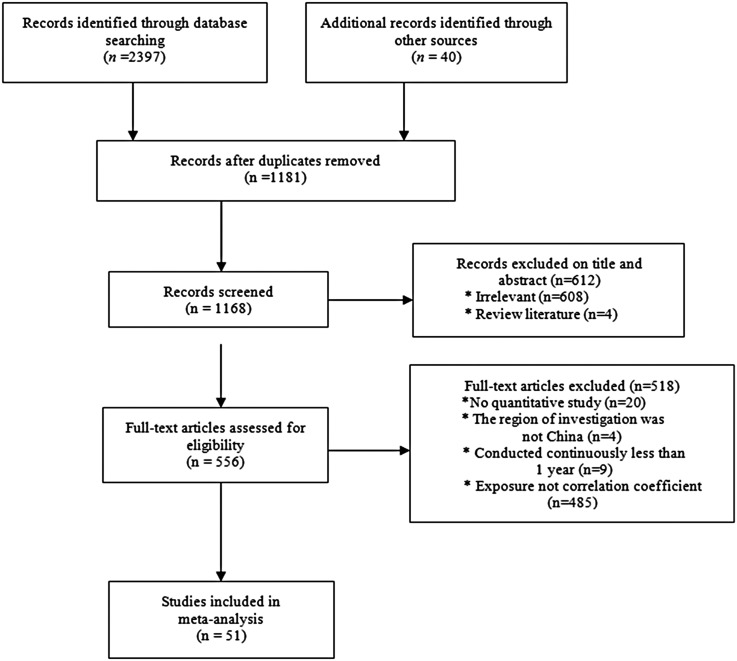
Flowchart of study selection.